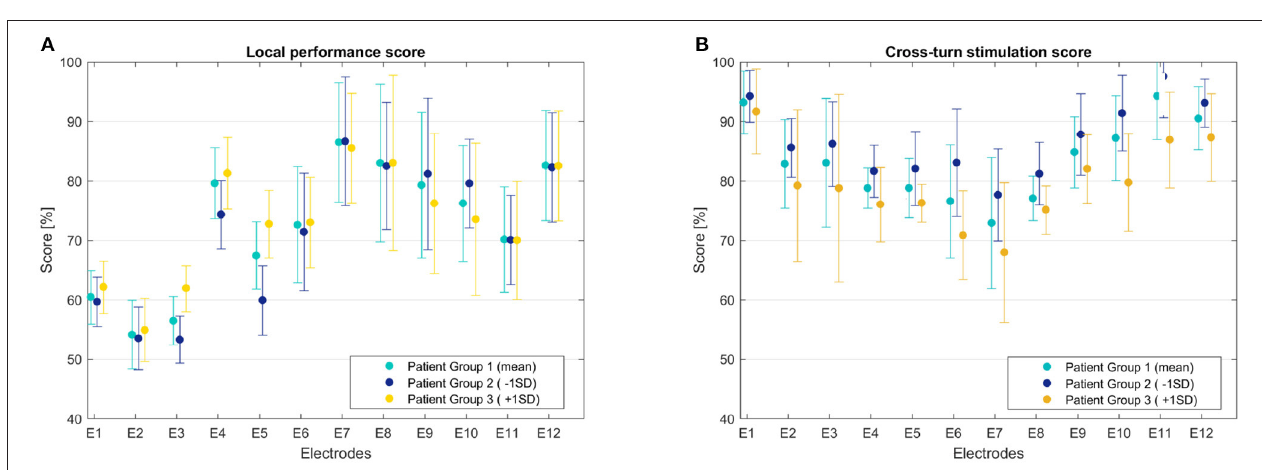
FIGURE 7 | Relation between the global performance and the length of the cochlea (A,B) in all the virtual population and (C) in each group of patients.